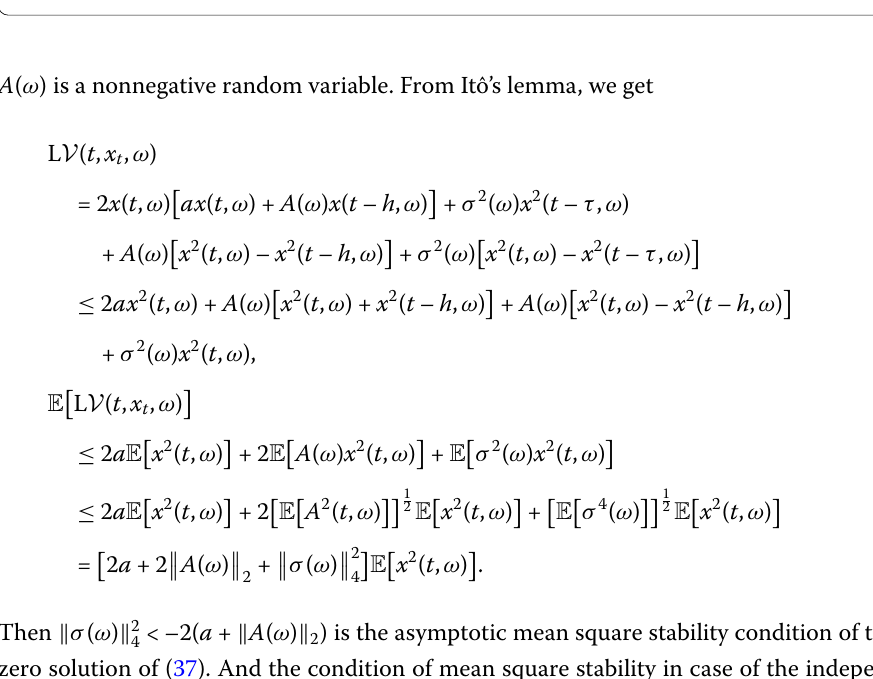
Figure 7 ( a ) Stability regions. ( b ) Trajectories of the